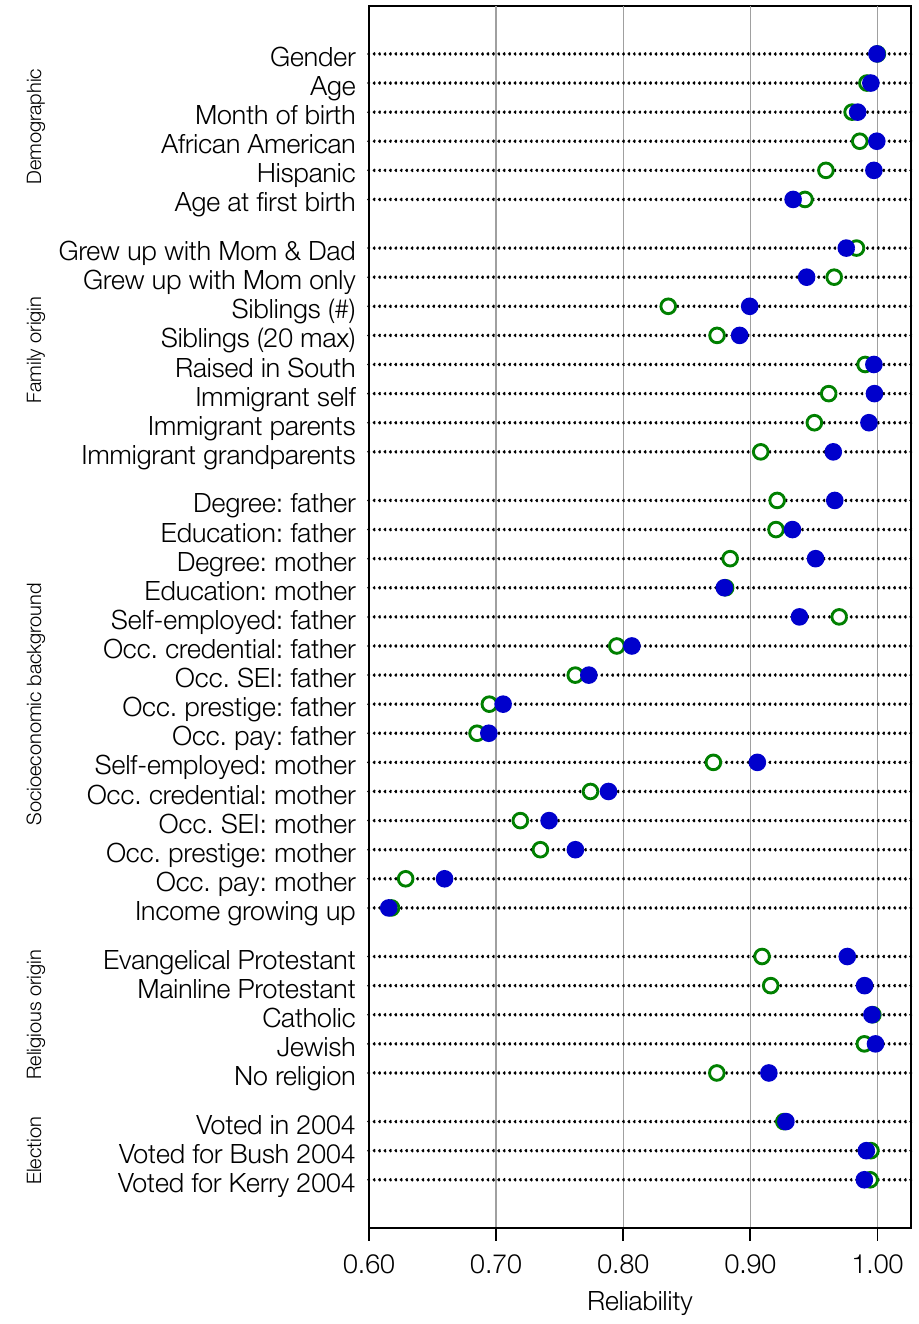
Figure 1: Reliability estimates for relatively fixed items: demographic, family, socioeconomic, religious, and election